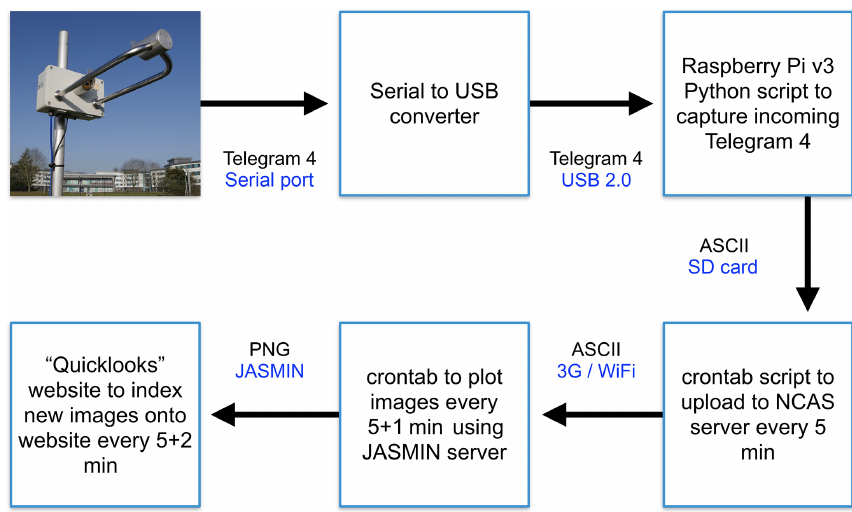
Figure 4. Flow chart of the sequence of data in the Disdrometer Verification Network. The instrument outputs a Telegram 4 format serial ping every minute, which is then captured by a Raspberry Pi (v3) running a Python script. The Python script then saves the file to the